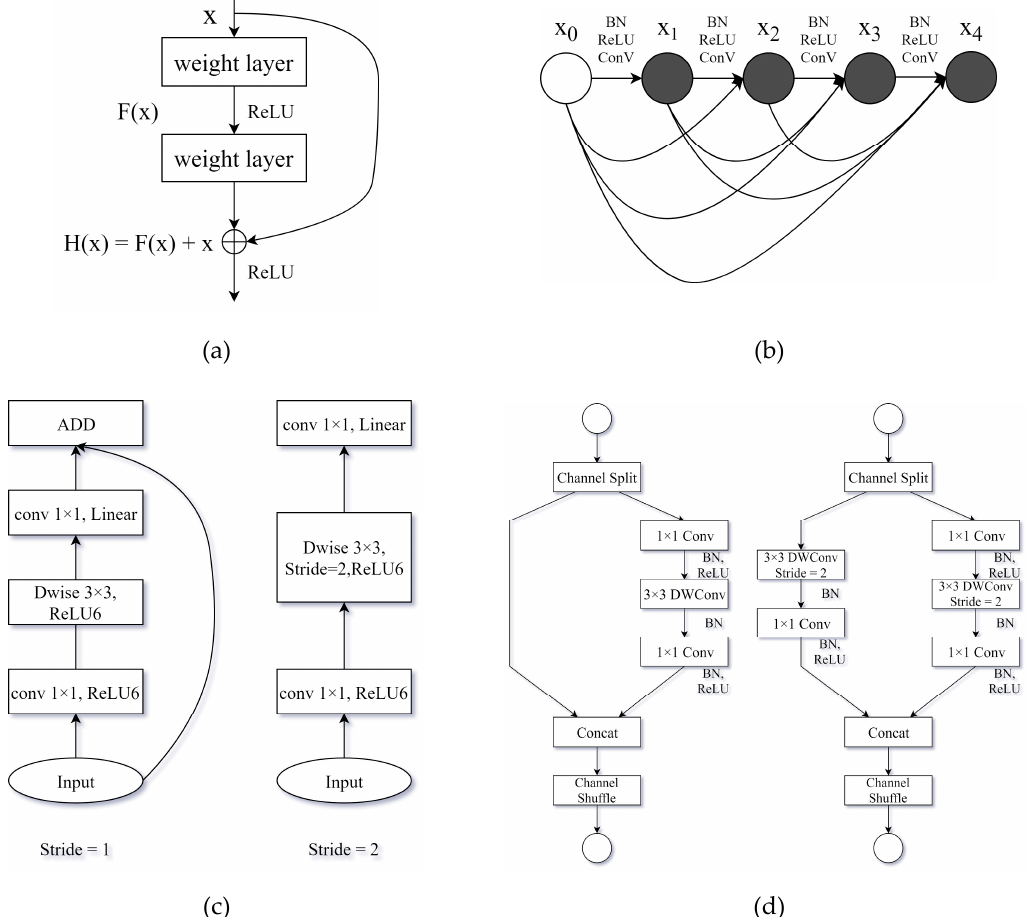
Figure 5. Various backbone networks: ( a ) the shortcut connection structure in ResNet; ( b ) the dense connection in DenseNet; ( c ) the inverted residual structure in MobileNetv2; ( d ) the channel shuffle structure in ShuffleNetv2.